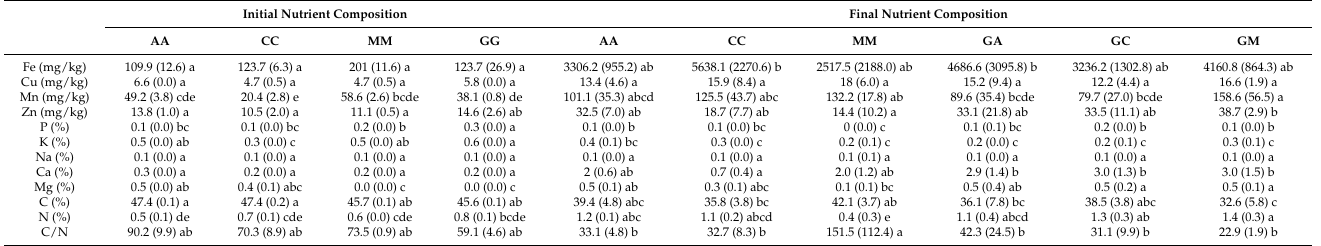
Table 2. Mean values of the initial and final nutrient composition in the bagged pruning and garden